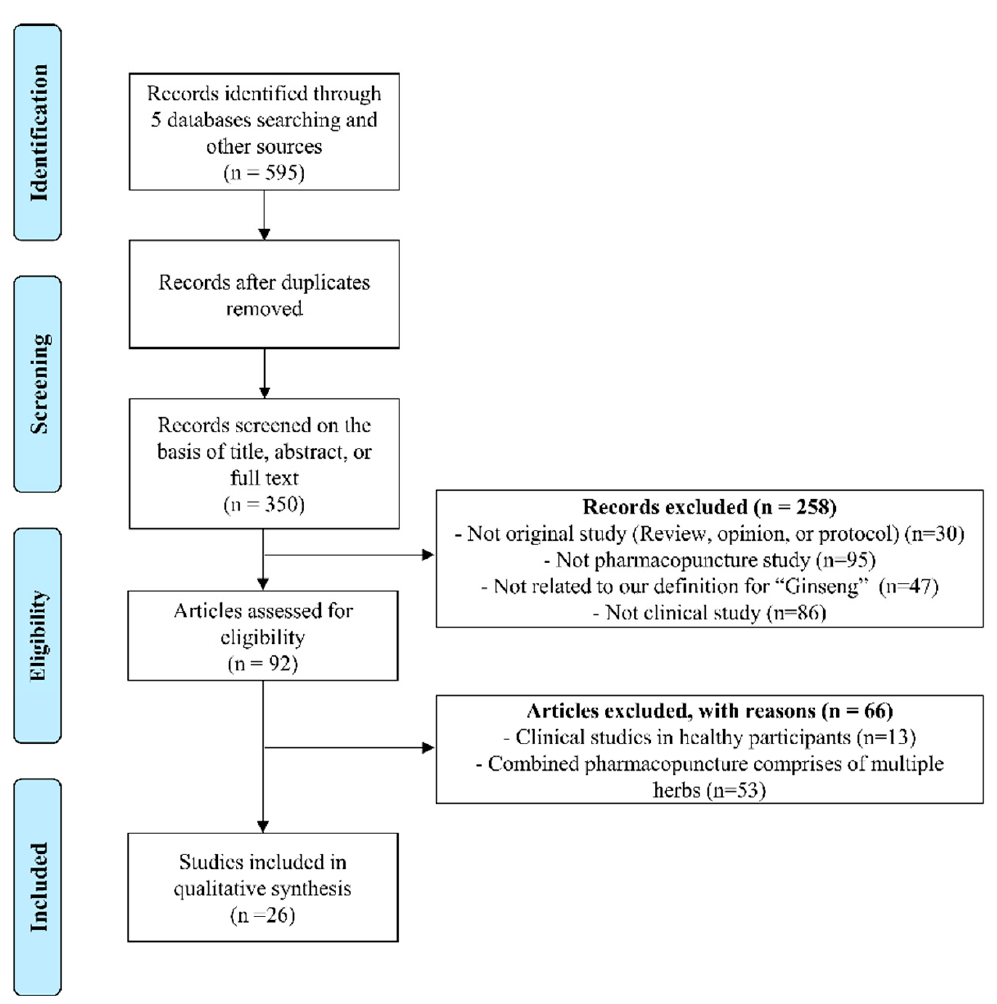
Figure 2. PRISMA flow chart for the search and selection of the included clinical trials.